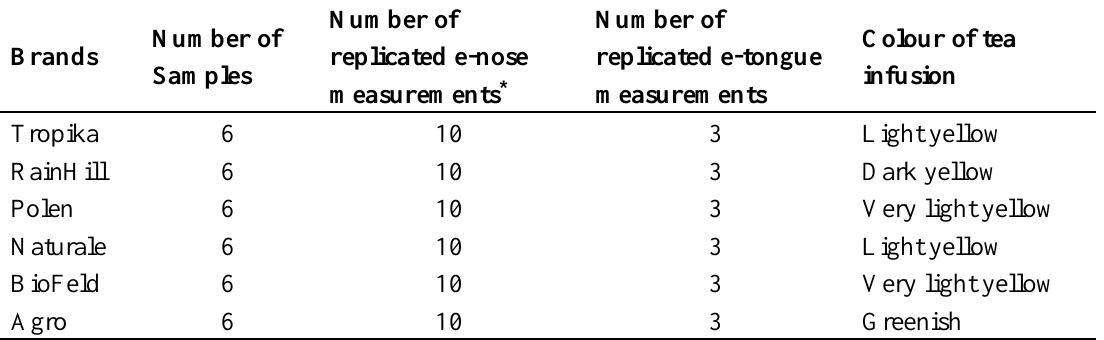
Table 1. Samples used in the experiments and number of replicated measurements.